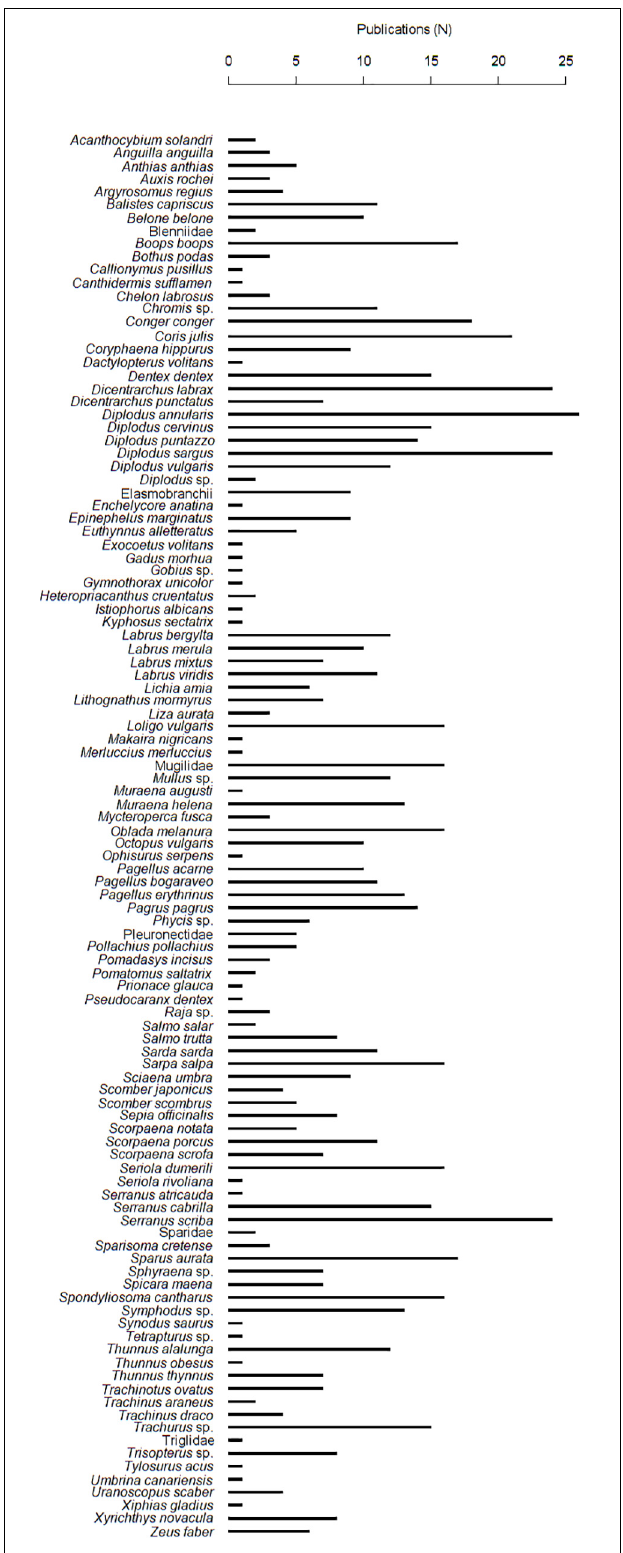
FIGURE 4 | Taxa studied in scientific texts about marine recreational fisheries in Spain published up to 2018.